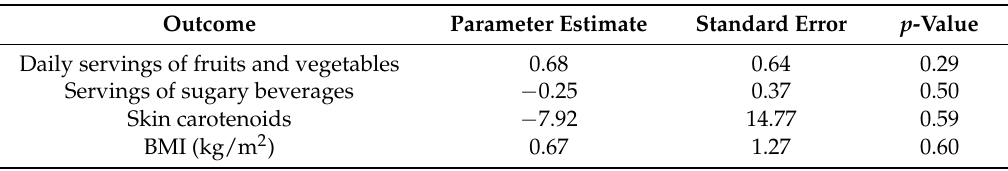
Table 6. Association between dietary outcomes of interest and HFSRP participation after 1 year of follow-up. Outcome Parameter Estimate Standard Error p -Value Daily servings of fruits and vegetables 0.68 Servings of sugary